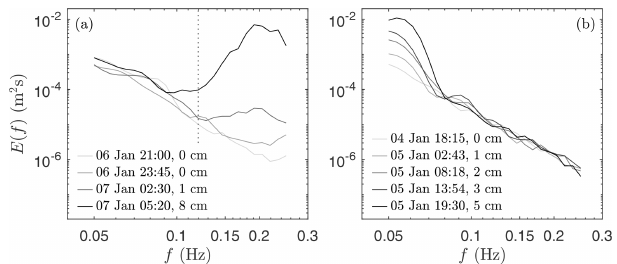
Figure 6. Wave energy spectra measured by (a) IB1 during the fourth identified sea ice break-up event and (b) IB2 during a swell event without sea ice break-up. The significant wave height of the spectra is provided in the legend; note that for (a) only the high- frequency part (i.e. f > 0 . 13) of the spectrum is considered (see dashed line). The spectra obtained on 6 January 2020 at 21:00 (a) and 4 January 2020 at 18:15 (b) correspond to the noise level of the IMU. Both the measured wind waves in (a) and swell in (b) are well above noise levels. Note that in (a) energy in the high-frequency part of the spectrum increases substantially after ice break-up, which is estimated to take place around 7 January at